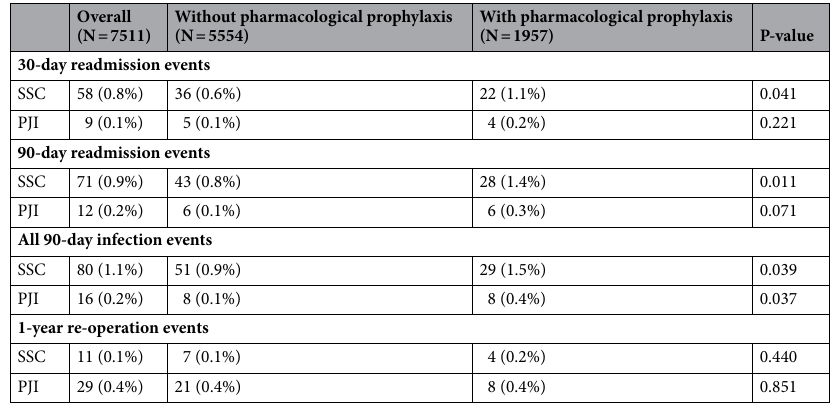
Table 2. Incidence of postoperative infection events. PJI: periprosthetic joint infection; SSC: surgical site complication.